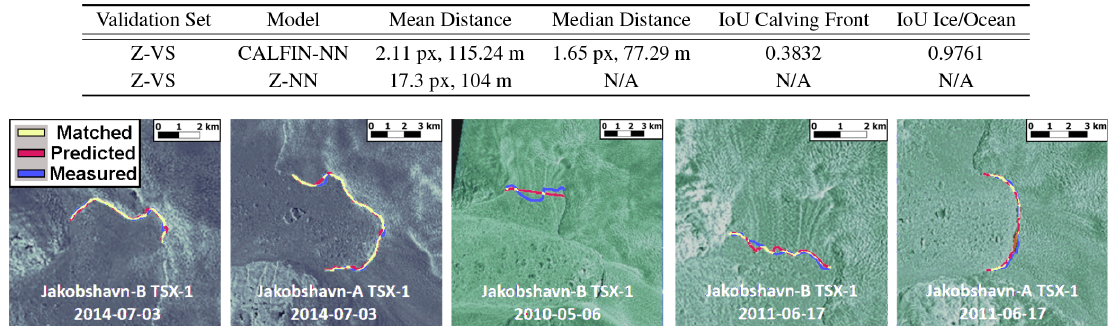
Figure 11. Z-VS validation output results. CALFIN-NN works well on SAR data in addition to optical data. See Fig. S10 for full outputs.